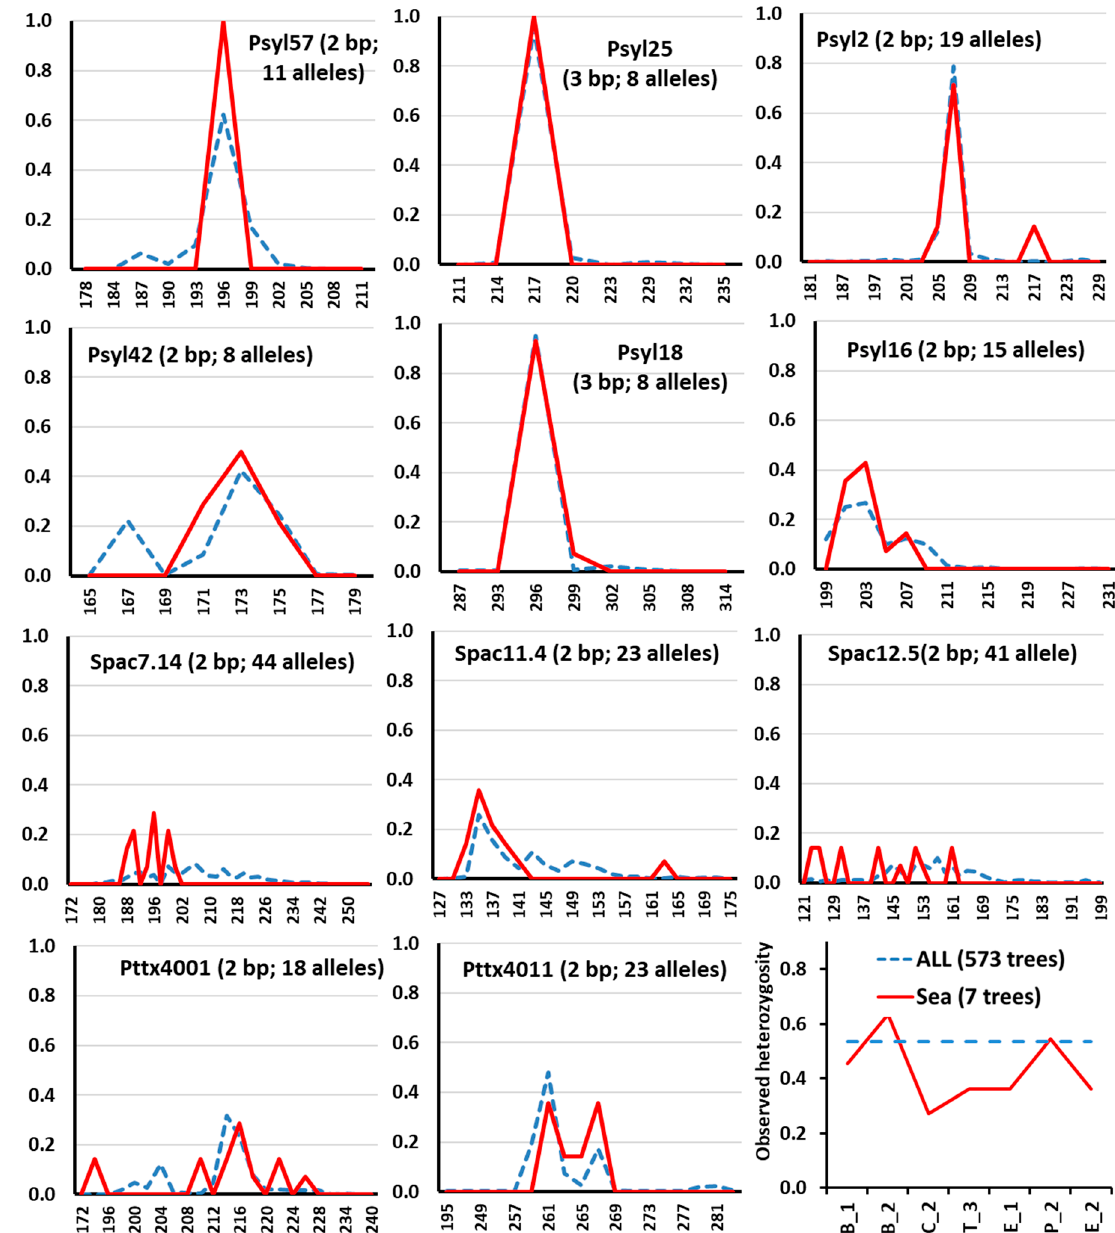
Figure 3. The observed heterozygosity (of all 11 loci, lower right) and locus allele frequencies of the 12,000-year-old sea pines (red solid line, seven trees, abbreviated as Sea) and the present-day Scots pine trees in Lithuania (dashed line, n = 573 trees, ALL). The microsatellite motive (in bp) and the number of different alleles per locus are given in the brackets at the locus name at the top of each plot. The Psyl loci are the expressed sequence SSR loci. The Spac loci are the genomic SSR loci. The most variable genomic SSR loci of Spac series display a consistent tendency for low allele sizes in the ancient Scots pine trees.